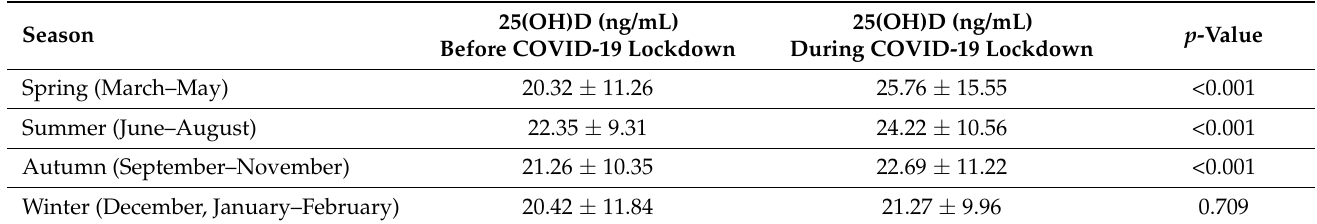
Figure 1. Comparison of 25(OH)D levels before and after the COVID-19 pandemic. These were compared by ( A ) gender and ( B ) age group. Table 3. Seasonal serum 25(OH)D levels before and during the COVID-19 lockdown period.